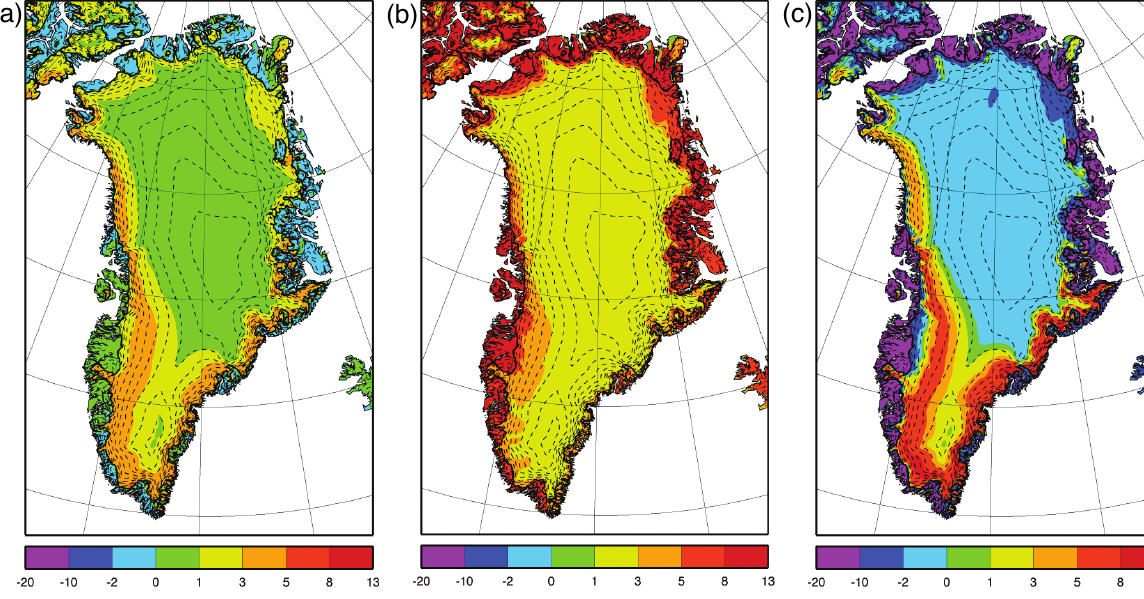
et al. (2008c). The summertime sublimation ( ∼ − 10 W m −